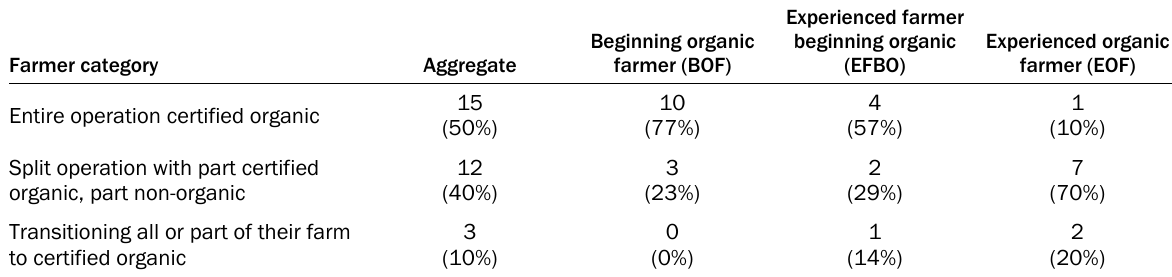
Table 4. Farm Status with Organic Certification